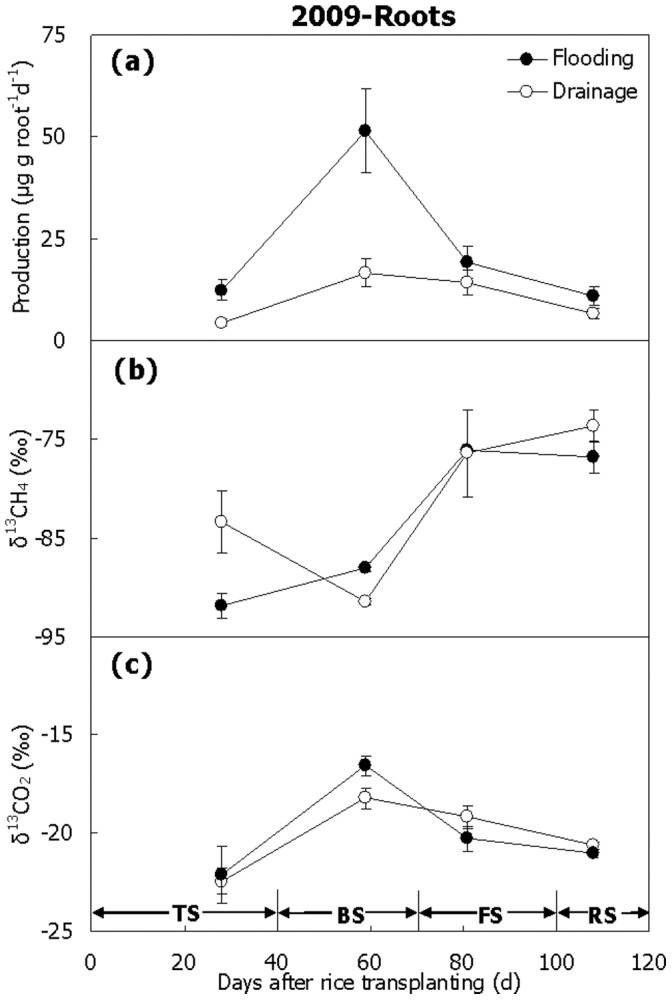
CH4 production potential and δ13C-values of CH4 and CO2 anaerobically produced on rice roots.(a) Potential, (b) δ13CH4, (c) δ13CO2. TS, BS, FS and RS represent tillering, booting, grain-filling and ripening stages, respectively. Bars represent standard errors (n = 3).